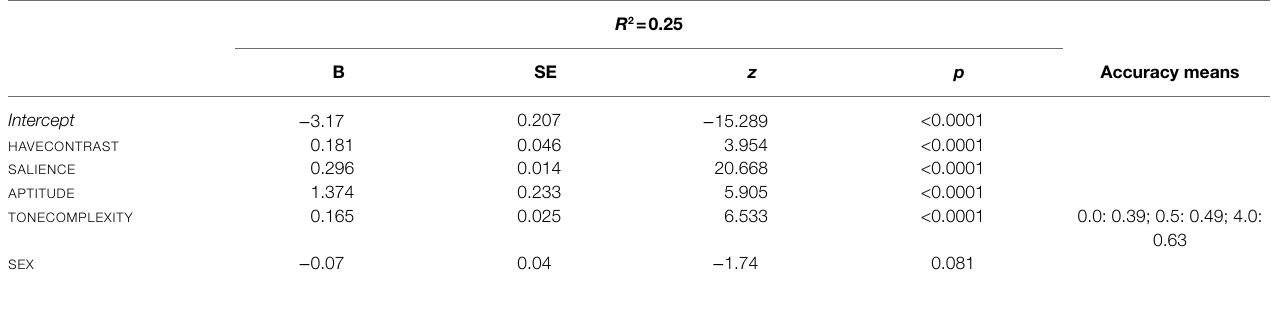
TABLE 6 | Results of a multiple logistic regression analysis with tone complexity as the tonality variable.